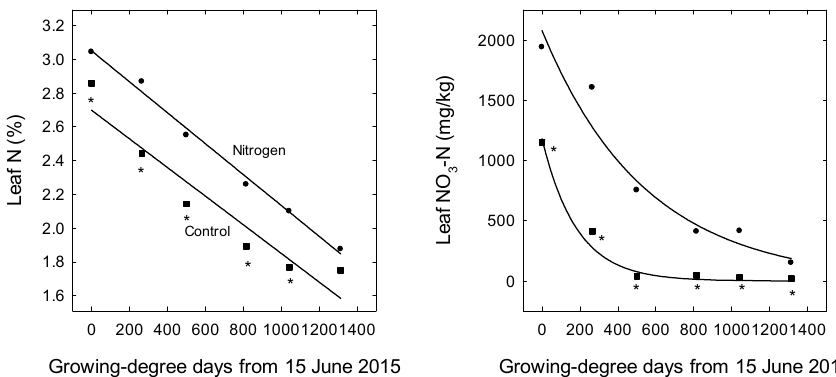
Figure 3. Effect of nitrogen (N) on the changes in the concentration of total N and nitrate-N (NO 3 -N) in young, fully expanded leaves of ‘Festival’ strawberry plants grown in Queensland, Australia in 2015. Data are pooled over two planting dates (mid- and late-April). Each symbol represents the mean of 12 replicates. Paired means with an asterisk are significantly different at p = 0.05. Control: leaf N = 2.70 − 0.0008 × GDD ( R 2 = 0.89) and leaf NO 3 -N = 1181 × exp. ( − 0.0055 × GDD) ( R 2 = 0.88). Nitrogen treatment: leaf N = 3.05 − 0.0009 × GDD ( R 2 = 0.99) and leaf NO 3 -N = 2079 × exp. ( − 0.0018 × GDD) ( R 2 = 0.94). Calculation of growing-degree days (GDDs) was based on a base temperature of 7 ◦ C.